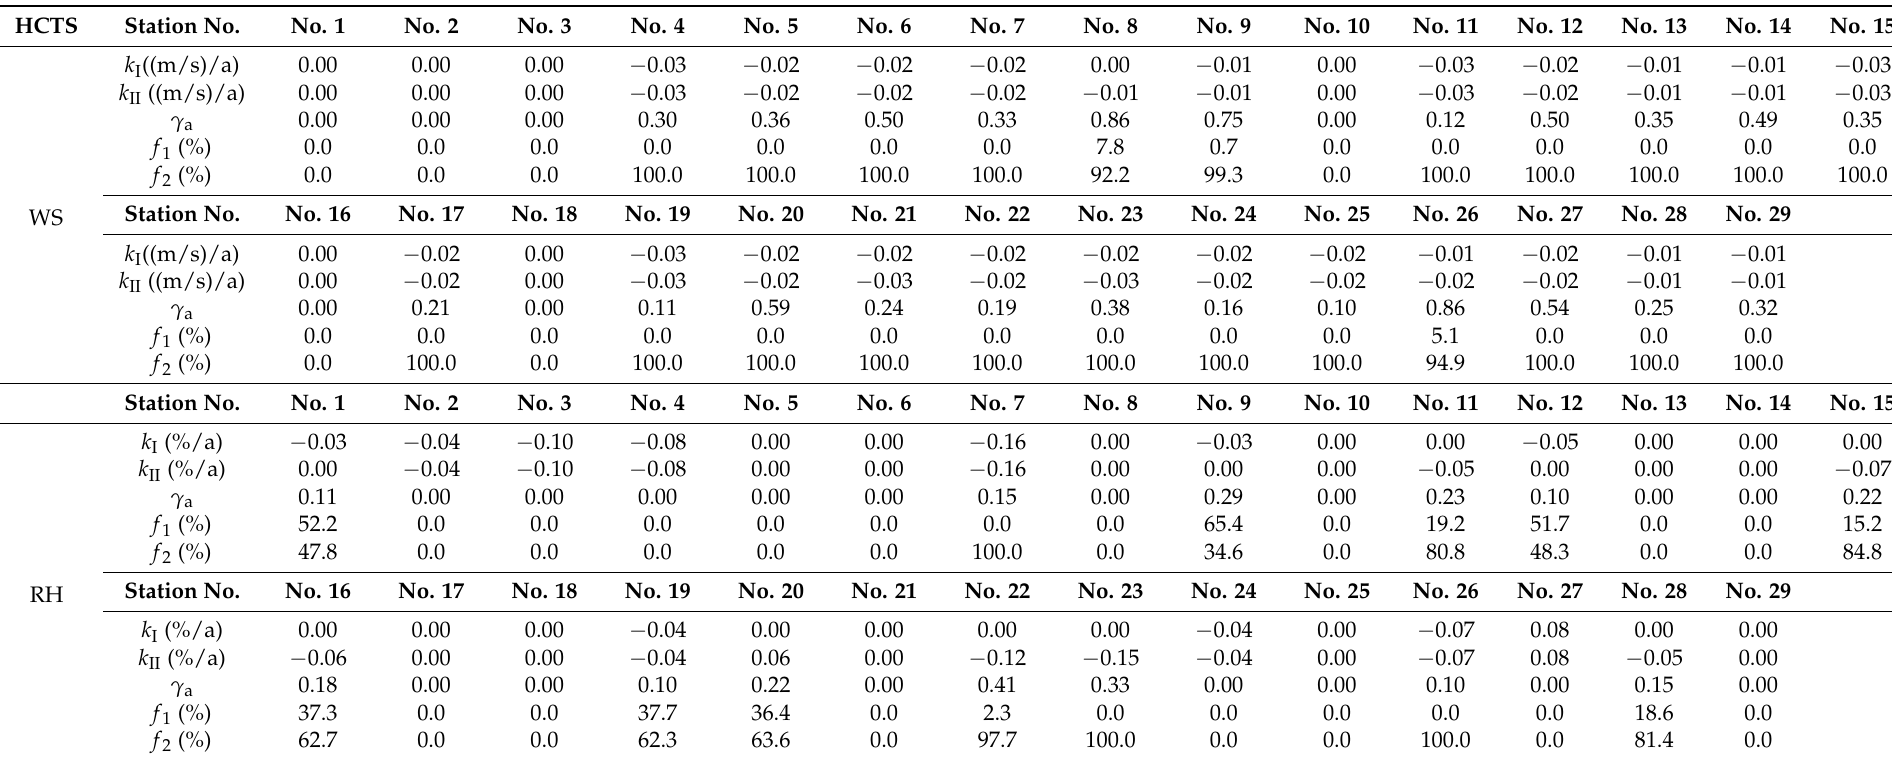
Table 5. Trend slopes and OW operation results for the annual WS and RH series in the HRB at the 5% significance level. HCTS Station No.